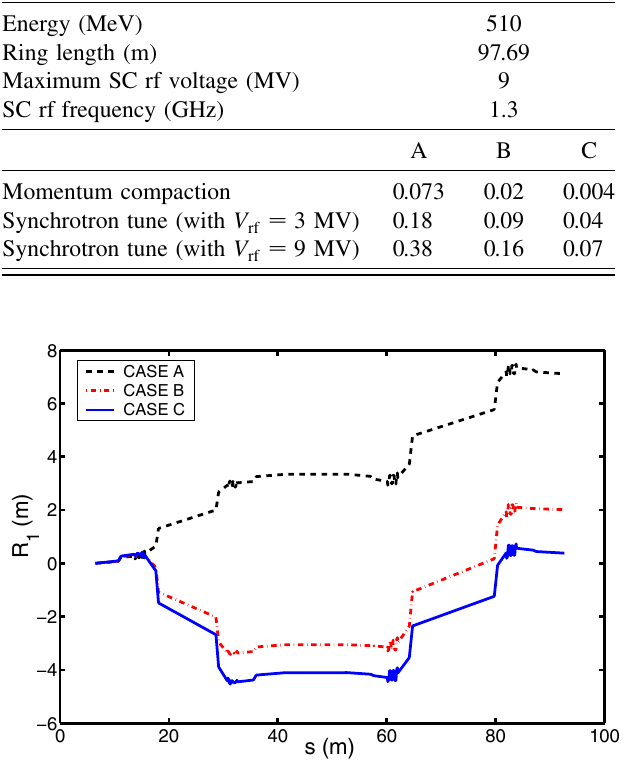
FIG. 5. (Color) Longitudinal drift function R the cases A, B, and